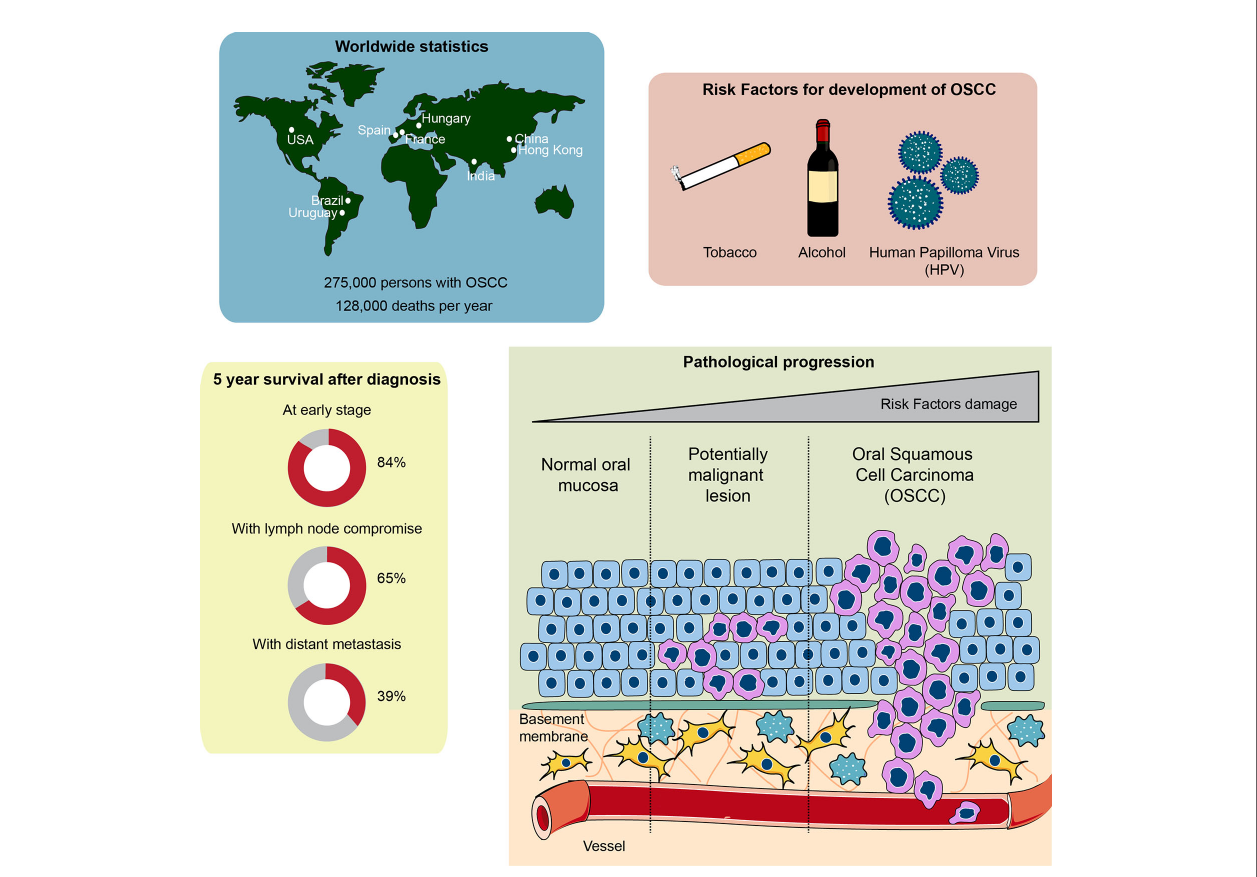
FIGURE 1 | Global statistics, survival rate, and pathophysiological features of oral squamous cell carcinoma (OSCC). Top left: countries with higher cases of OSCC diagnosed around the world. Top right: the main risk factors involved in OSCC development and progression. Bottom left: chances of survival 5 years after being diagnosed with OSCC. Note that early diagnosis of OSCC is crucial to ensure over 80% survival chance after 5 years. The general statistics show a 50% survival rate after 5 years, given that OSCC is usually diagnosed late. Bottom right: development of OSCC from a normal oral epithelium. The normal epithelium, composed of epithelial cells known as keratinocytes, is located over a basement membrane that separates the epithelium from the connective tissue composed of fi broblasts, immune cells and vessels. Exposure to carcinogens derived from the risk factors of the top right panel generate a potentially malignant lesion, characterized by an altered cellular morphology that starts affecting the inner layers of the epithelium close to the basement membrane, progressing toward the outer layers of the epithelium. Continuous exposure to carcinogens leads to OSCC development, a phenomenon that alters all the epithelial cell layers both genetically and morphologically. Interplay between connective tissue cells and OSCC cells is also observed, which assists OSCC growth and